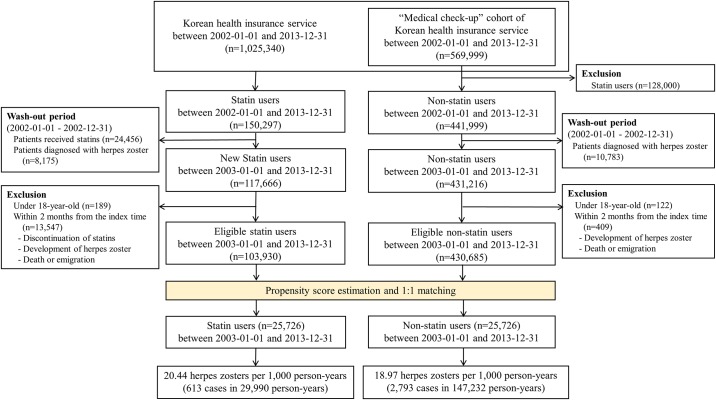
Flow diagram of the study.Flow diagram giving details of the enrolled individuals, and the procedure for propensity score matching.